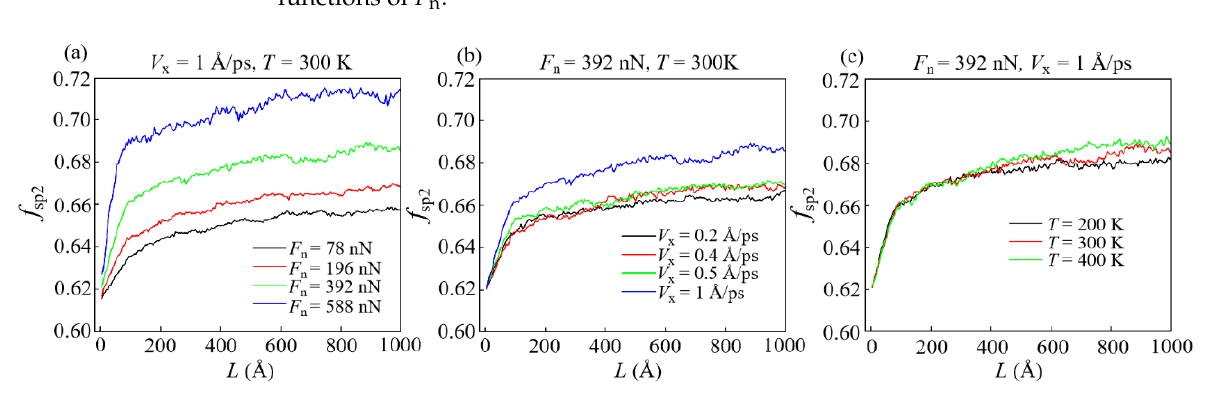
Figure 4. Influence of different conditions on the fraction of sp 2 -C atoms f sp2 of DLC films : ( a ) V x = 1 Å /ps, T = 300 K; ( b ) F n = 392 nN, T = 300 K; ( c ) F n = 392 nN, V x = 1 Å /ps.